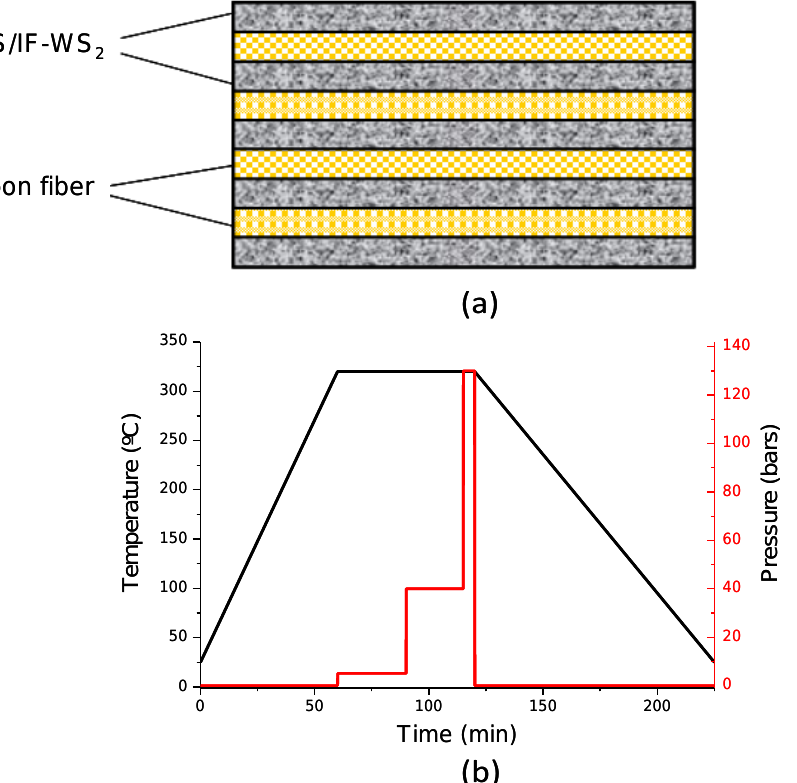
Figure 8. ( a ) Laminate stacking sequence; and ( b ) consolidation cycle used for the fabrication of the laminates.